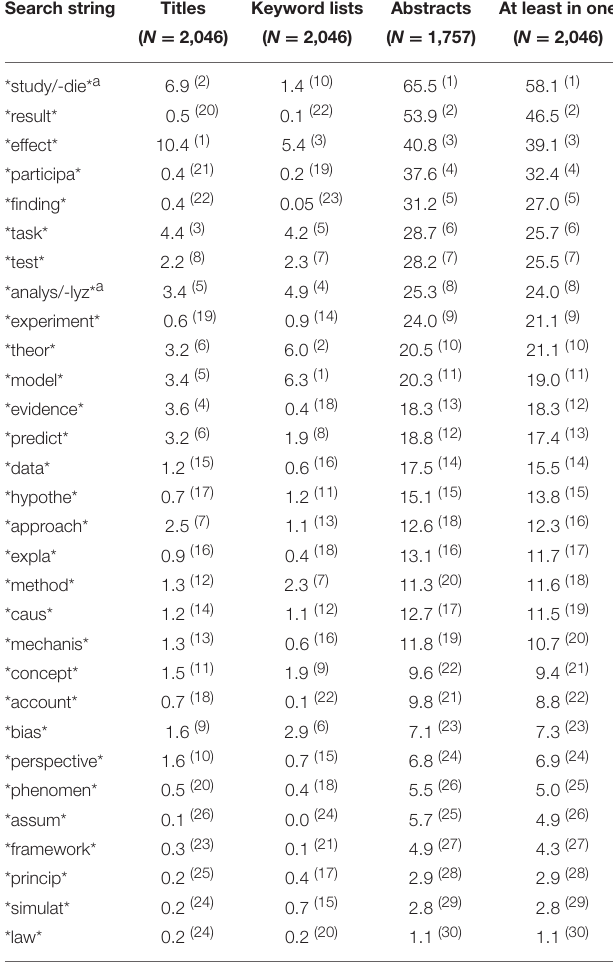
TABLE 3 | Percentage of the titles, keyword lists, and abstracts, in which a search string matched, as well as percentage of articles with at least one match in any